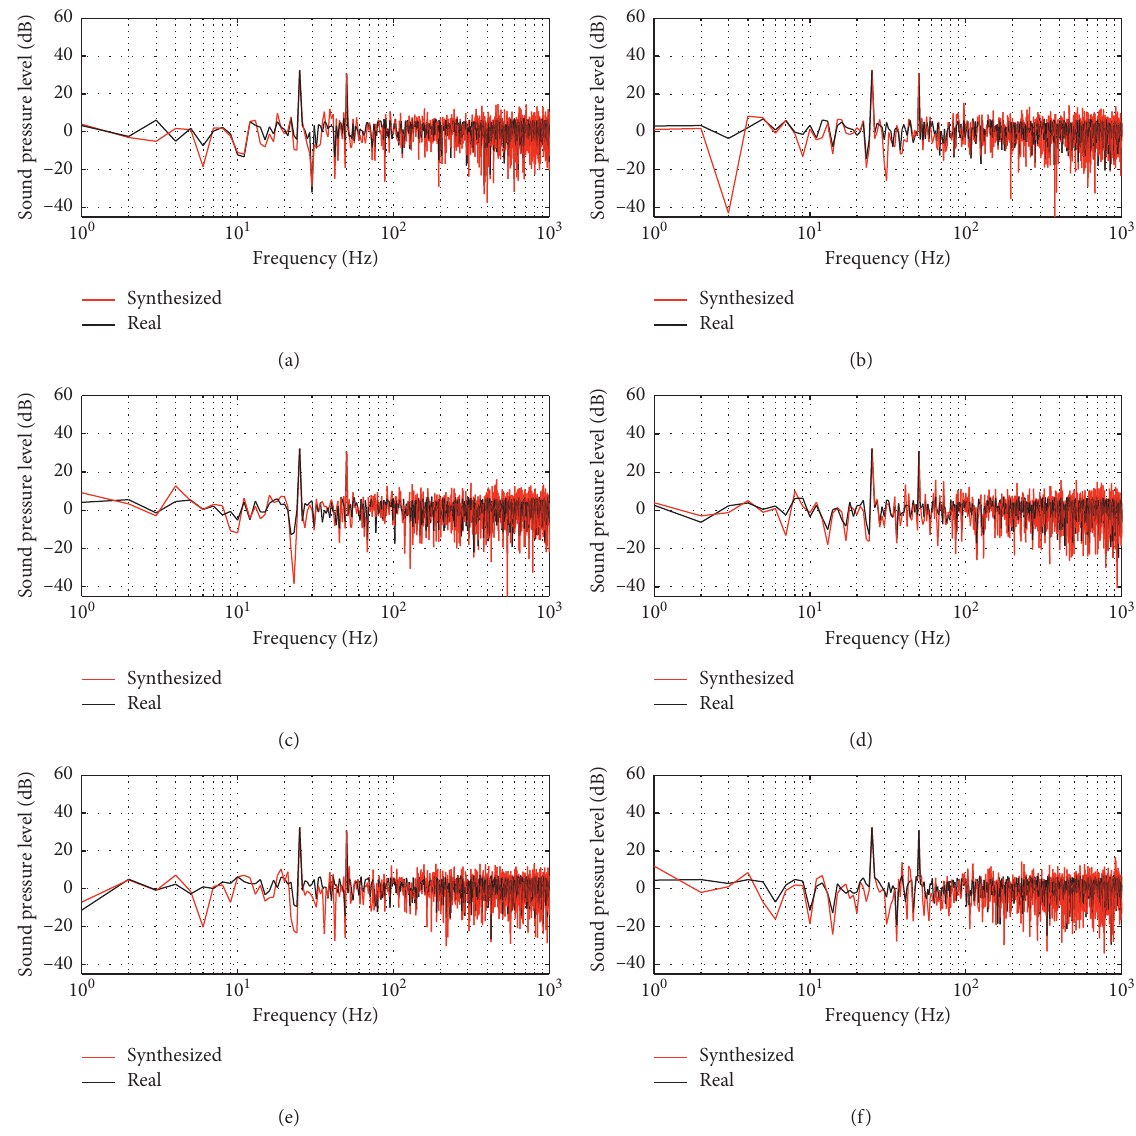
Figure 7: Sound pressure level of the numerical study for 6 different blocks: (a) measurement block 1; (b) measurement block 2; (c) measurement block 3; (d) measurement block 4; (e) measurement block 5; (f) measurement block